Question: Write a descriptive caption for this figure.
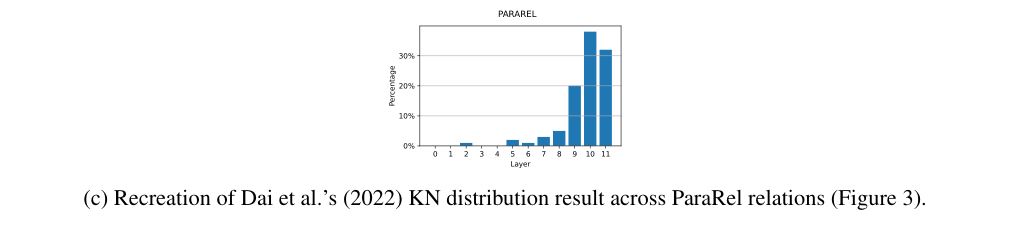
Answer: Percentage of knowledge neurons identified in different BLiMP paradigms using BERT.